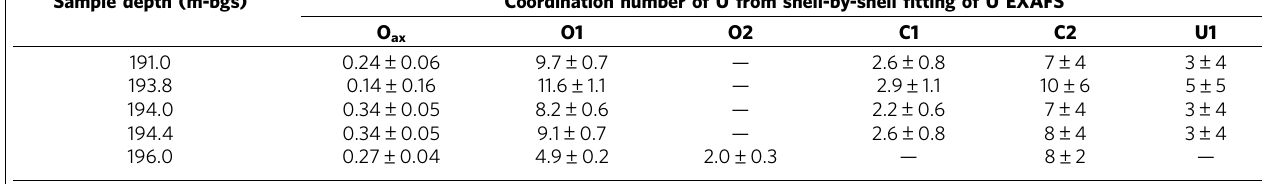
Table 2 | U speciation from EXAFS analysis within given sample depths (m-bgs). Sample depth